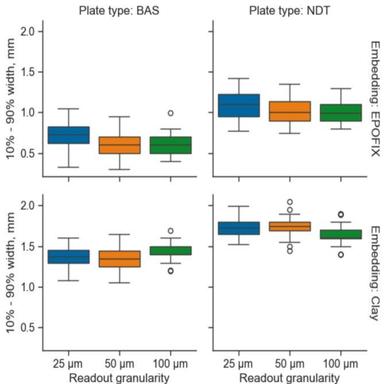
Comparison of edge width categorical box plots for different IP types, embedding materials, and readout granularities. The vertical axis range has been fixed across all sub-plots to enable direct comparisons of categorical variables. The results for BAS imaging plate are displayed in the first column, while NDT results are shown in the second column. The first row represents samples with EPOFIX embedding, and the second row represents modelling clay embedding.